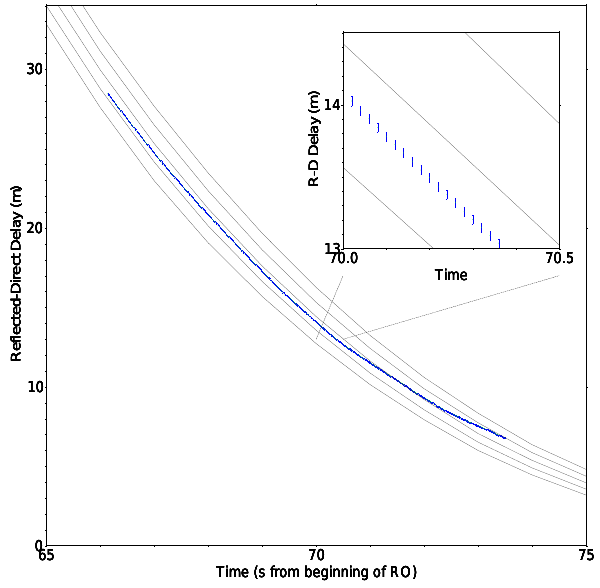
Fig. 6: Comparison between interferometric delay (observables with error bars) and the ray tracer simulated observables, based on the ECMWF atmospheric profile. A 1-dimensional family of profiles is explored, varying the refractivity in steps of 1% . From left to right, the curves represent the raytracing over 0.98, 0.99, 1.00, 1.01 and 1.02 times the ECMWF profile.